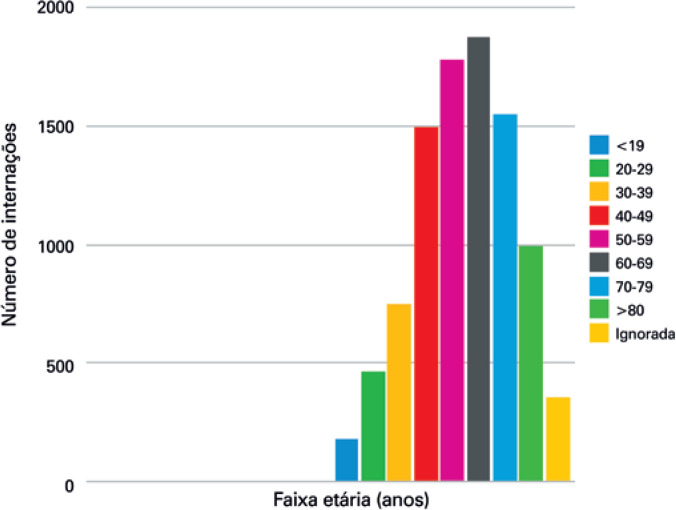
Distribuição com estratificação etária das internações por câncer de pênis no Brasil, de 1992 a 2017